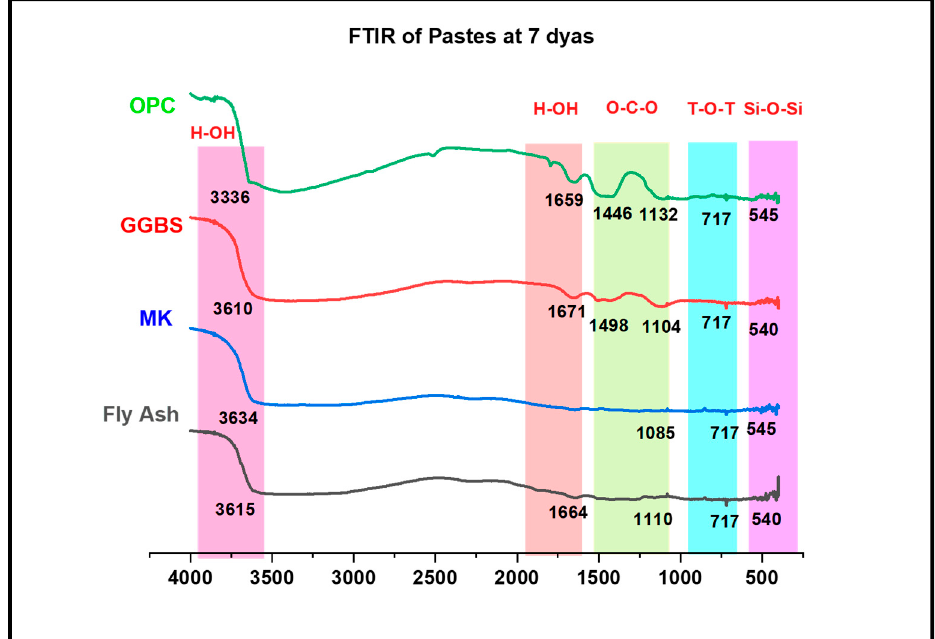
Figure 20. FTIR of Pastes at 7 days of curing.